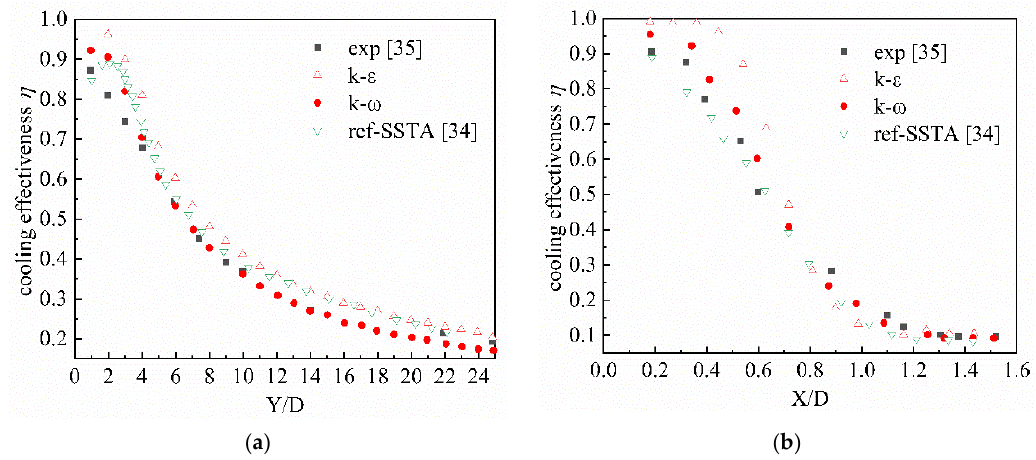
Figure 9. Validation of the computational method: ( a ) central line, ( b ) span-wise line.